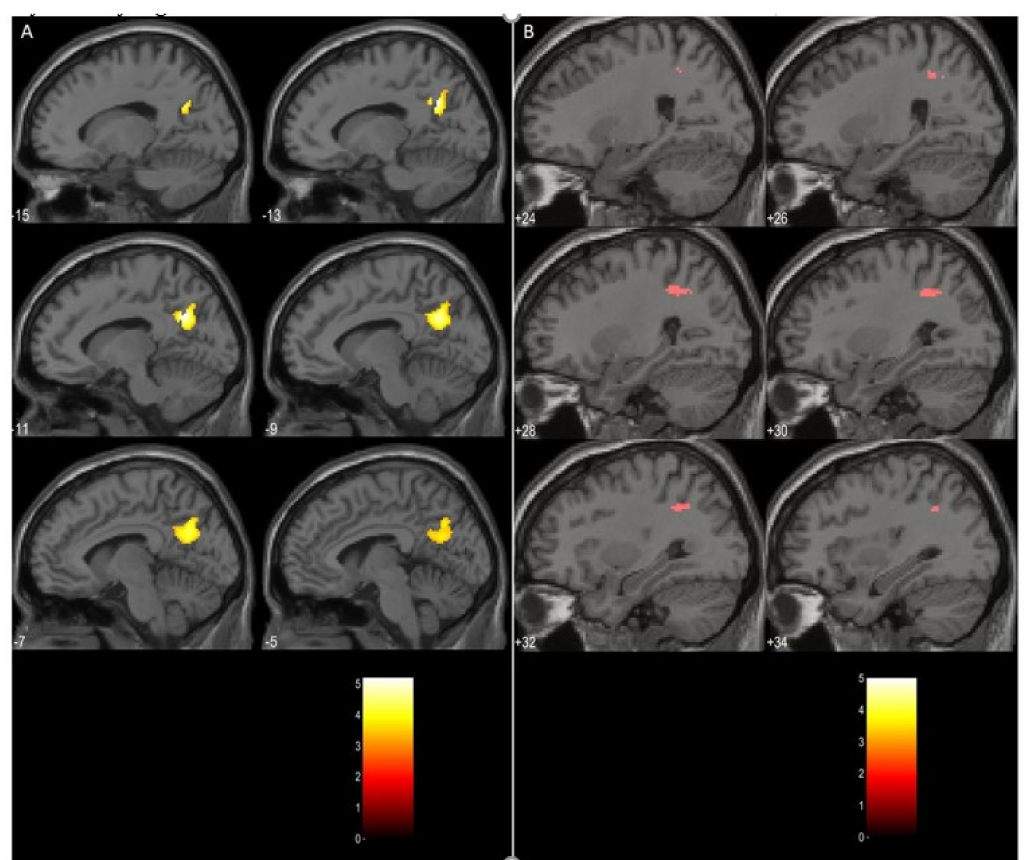
Figure 1. Clusters of activations significantly higher in schizophrenia ( A )—left precuneus; ( B )—right posterior parietal